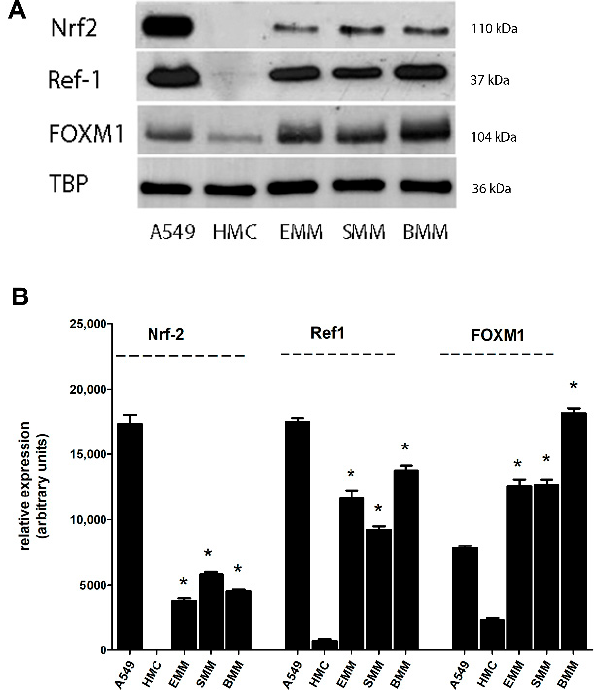
( B ) Densitometric analysis of the expression levels of Nrf2 ( n = 3, * p < 0.001), Ref-1 ( n = 3, * p <